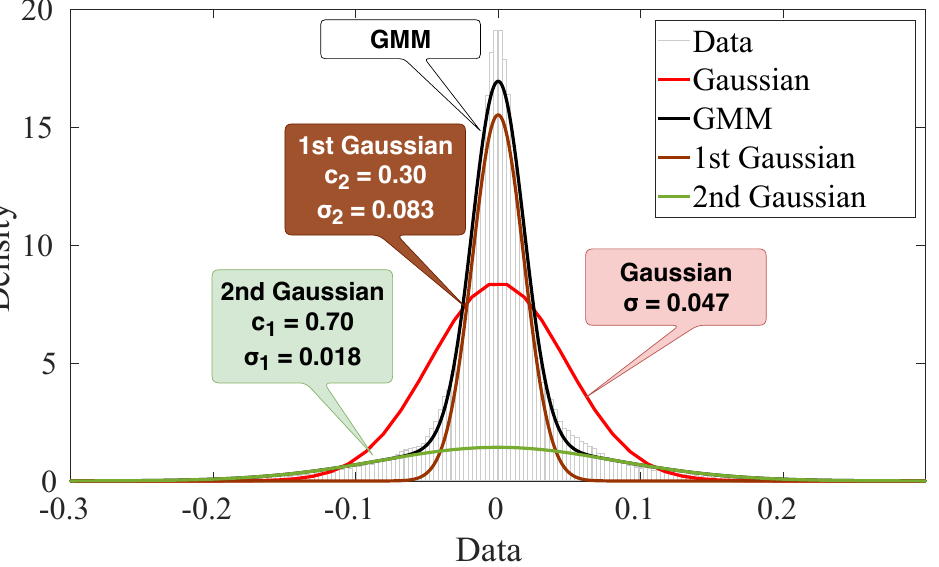
Figure 12. Illustration of Gaussian mixture model fitting with two Gaussians (data from the outdoor scenario in a time window with severe impulsiveness).